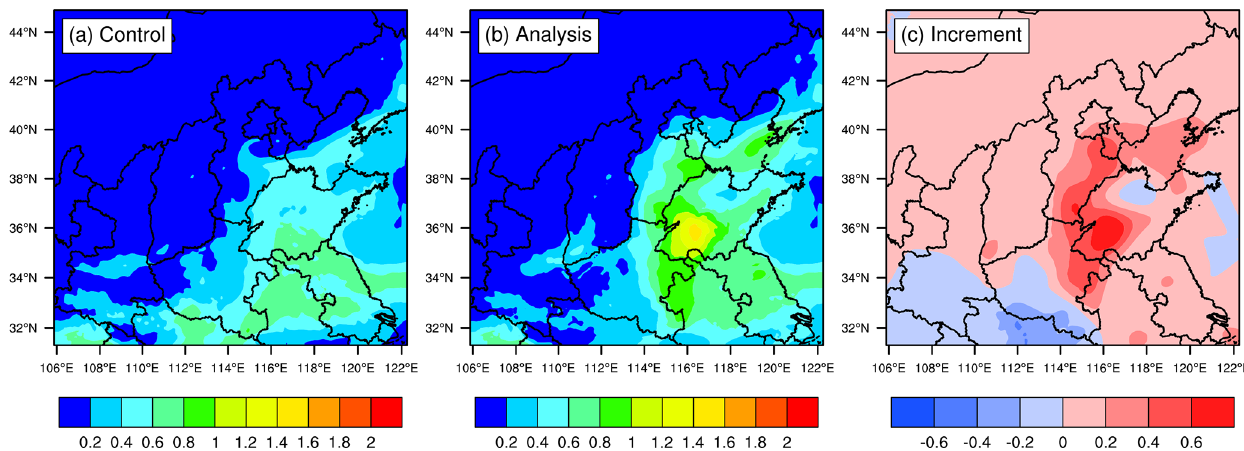
Figure 6. Spatial distributions of simulated AOTs in the background field (a) and analysis (b) and the increments (c) , which are differences between the analysis and the background field. For illustration, distributions in D02 at a model initialization of 03:00UTC on 25 November 2018 are given, which are similar to other results during the experiment period (i.e., from 23 to 29 November 2018).